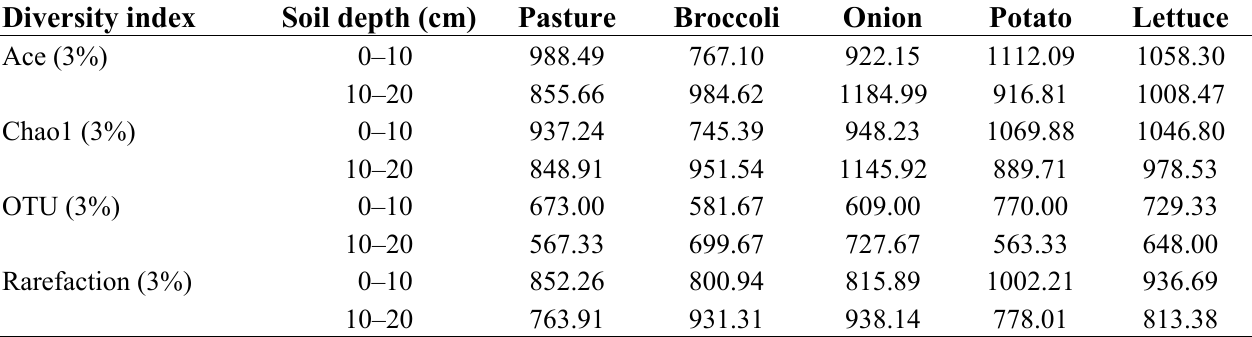
Table 4. Soil bacterial diversity indexes studied under different rhizospheres in an organic production